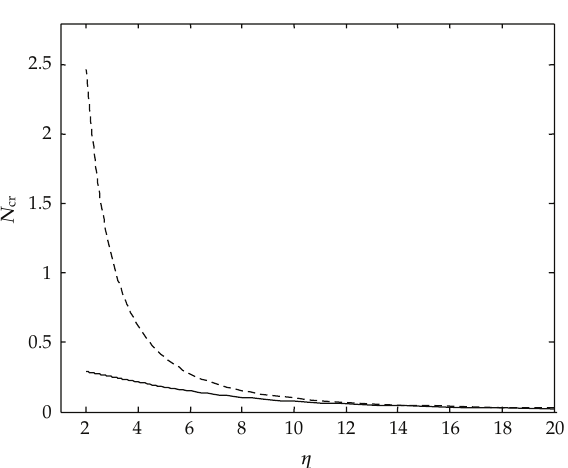
Figure 7: Variation of the critical buckling load (cid:2) N cr (cid:3) versus slenderness ratio for di ff erent beam models (cid:2) - - - (cid:3) Bernoulli-Euler’s and Rayleigh’s, (cid:2) — (cid:3) shear and Timoshenko’s beam models.